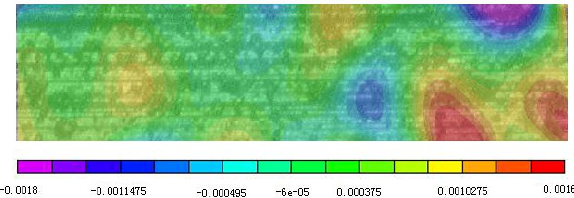
Figure 24: Strain